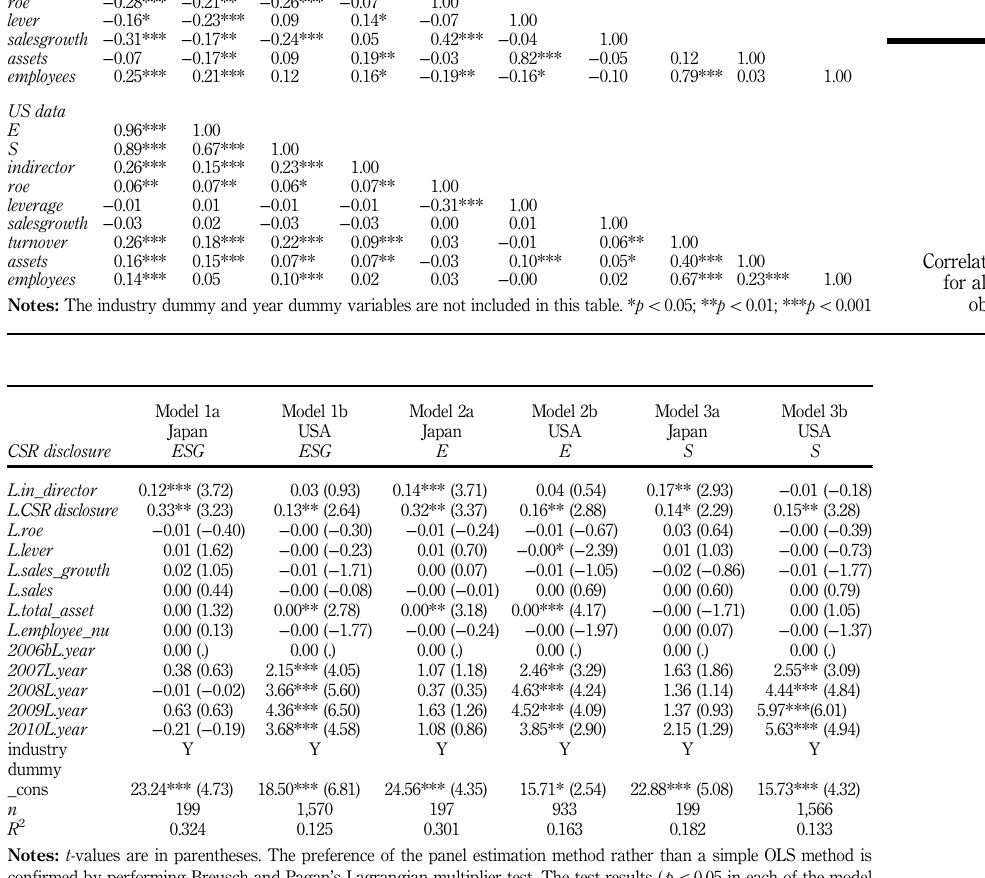
Table III. Results of fixed effects regressions on the level